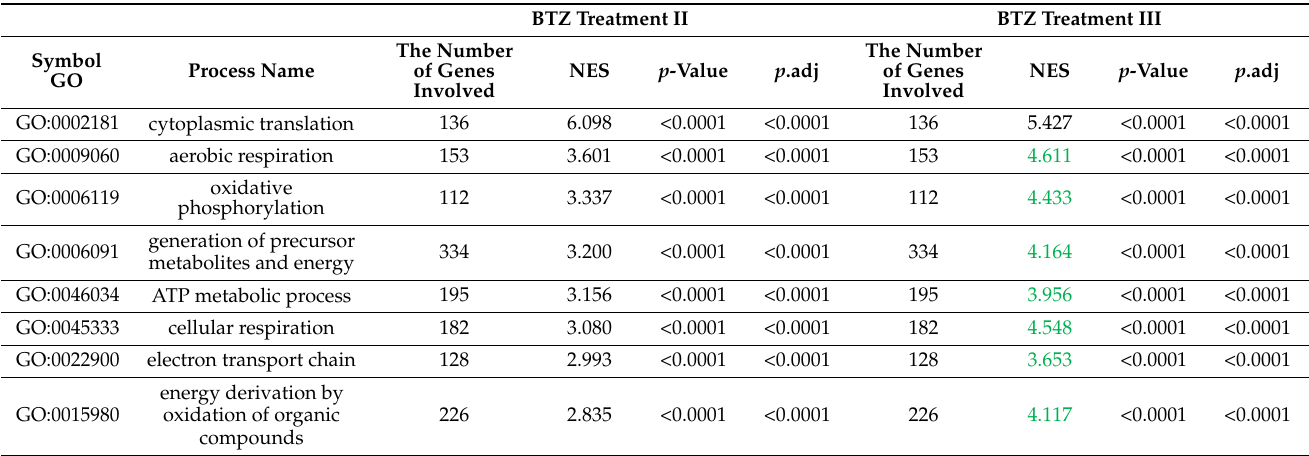
Table 1. Comparison of NES values of the processes activated after second and third treatments with BTZ of U266 myeloma cells. Data compiled on the basis of GSEA analysis. BTZ Treatment II BTZ Treatment